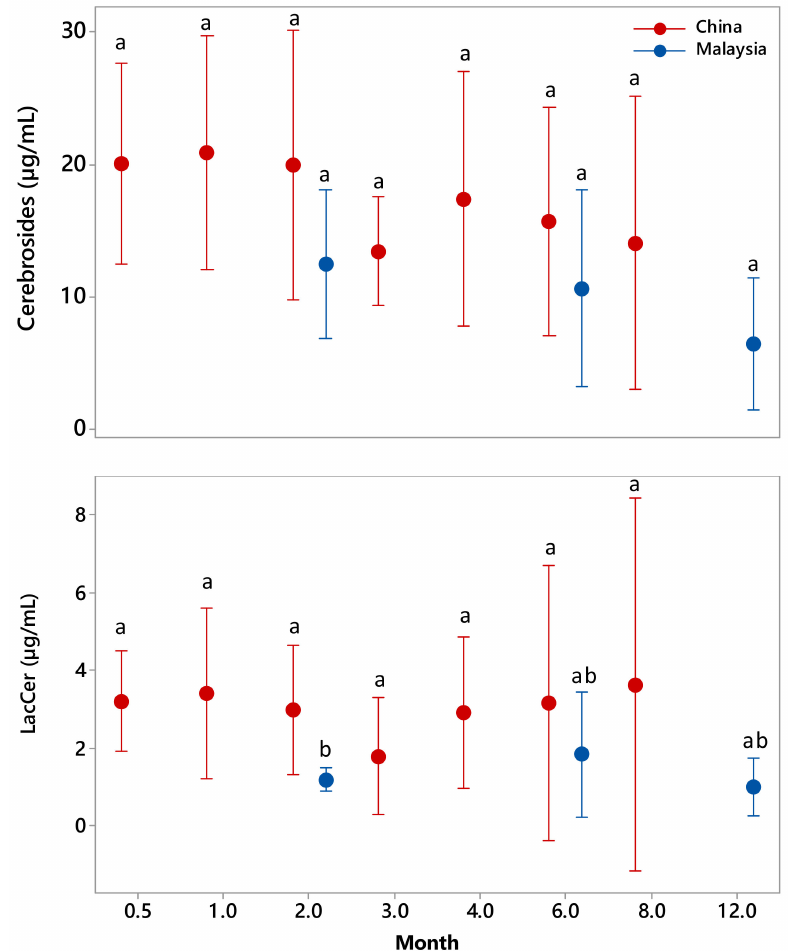
Figure 8. Lactational changes in the concentration of Crb (top panel) and LacCer (bottom panel) in human milk from cohorts of Chinese and Malaysian mothers. The results are at 95% confidence. Data with the same letter indicate no statistically significant di ff erence by one-way analysis of variance or two-sample t-test analysis ( p >